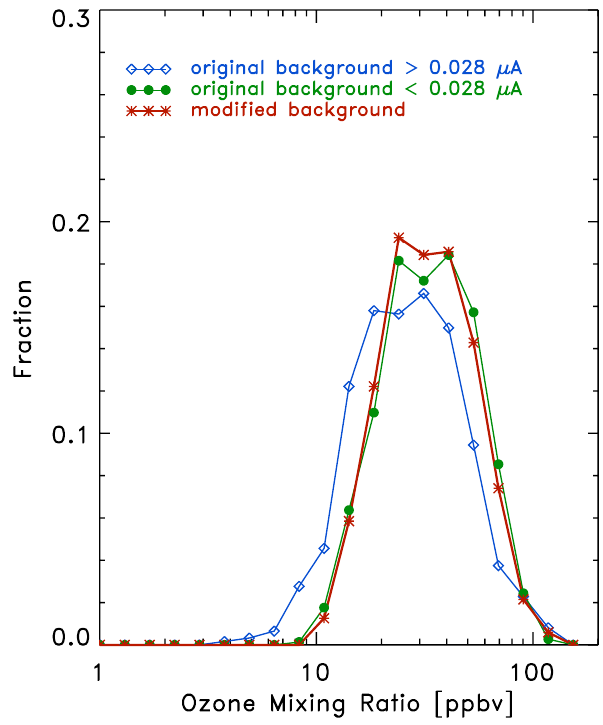
Fig. 6. Model 5A sonde cell current profiles for October 1992 and October 1993 soundings at South Pole in blue and for CEPEX soundings in red. The background current used for the CEPEX ob- servations (0.065µA) is shown for reference as vertical dotted line.